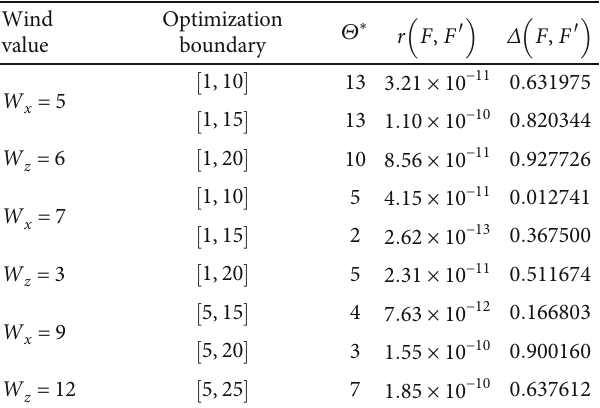
Table 2: Convergence and diversity of Pareto front obtained from constant wind simulation. Wind Optimization Θ ∗ r F , F value boundary